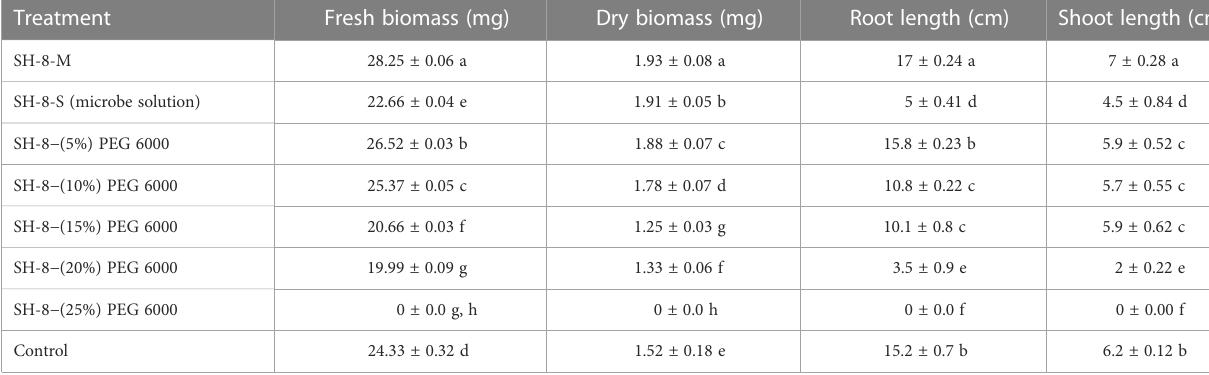
TABLE 3 Biomass and early seedling characteristics of the drought-treated seedling (root and shoot length grown for 8 days).